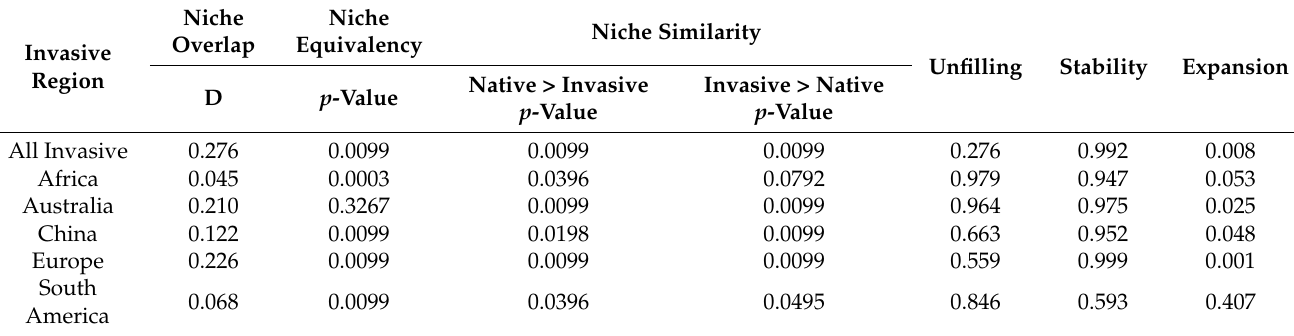
Table 1. Niche overlap index (Schoener’s D), niche equivalence test and similarity test p -value, and niche dynamic index between the native range and invasive regions of A. artemisiifolia .